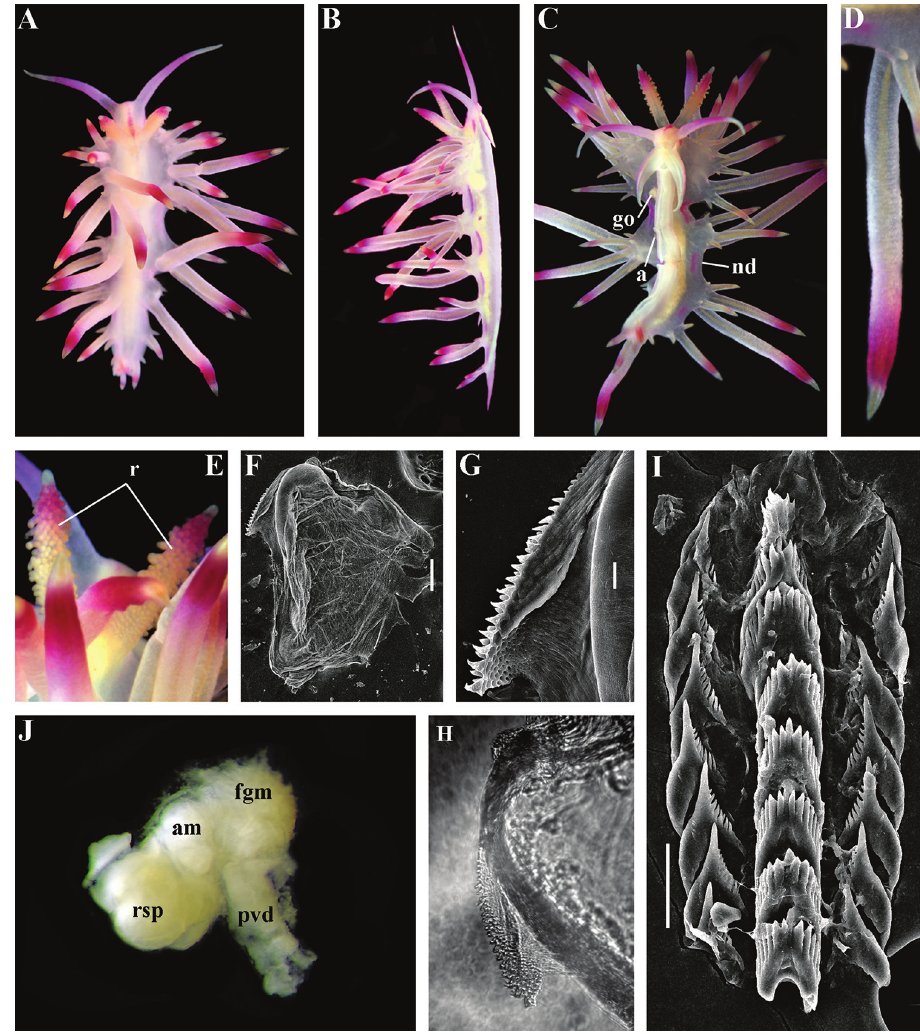
Figure 38. Coryphellina lotos sp. n. Japan, Pacific Honshu, Osezaki. ZMMU Op-515, living specimen 15.5 mm in length: A dorsal view B lateral view C ventral view D details of cerata E rhinophores, close up F jaw SEM G details of masticatory process of jaw, SEM H details of masticatory process of jaw, light microscopy I radular teeth, posterior part, SEM J reproductive system, light microscopy. Abbreviations: a anus am ampulla fgm female gland mass go genital opening nd discontinuous notal edge pvd pros- tatic vas deferens r rhinophores rsp proximal receptaculum seminis. Scale bars: F = 100 μm; G = 20 μm; I =50 μm. Photos and SEM images by T.A. Korshunova, A.V.